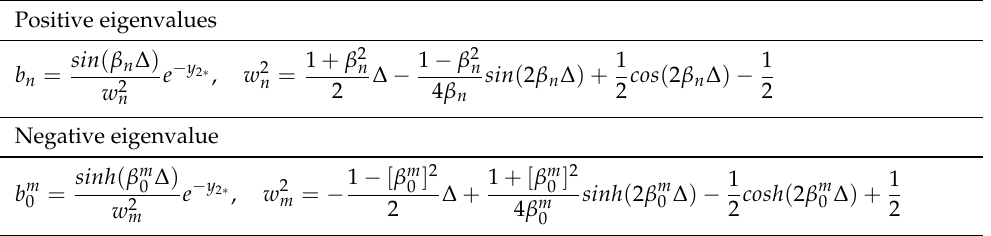
of the transitional solution ( b p 0